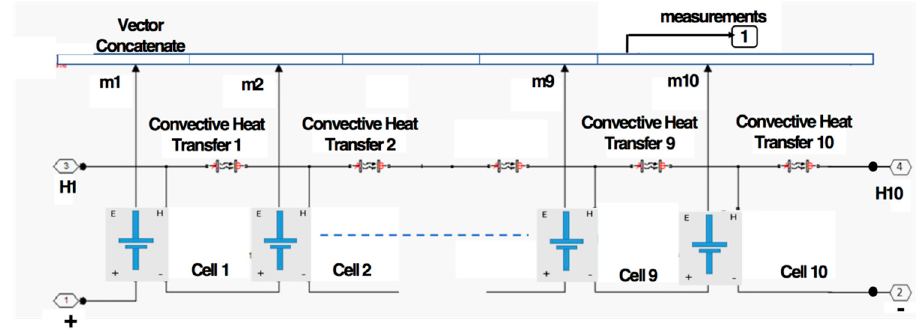
Figure 3. The 10 cell battery pack.